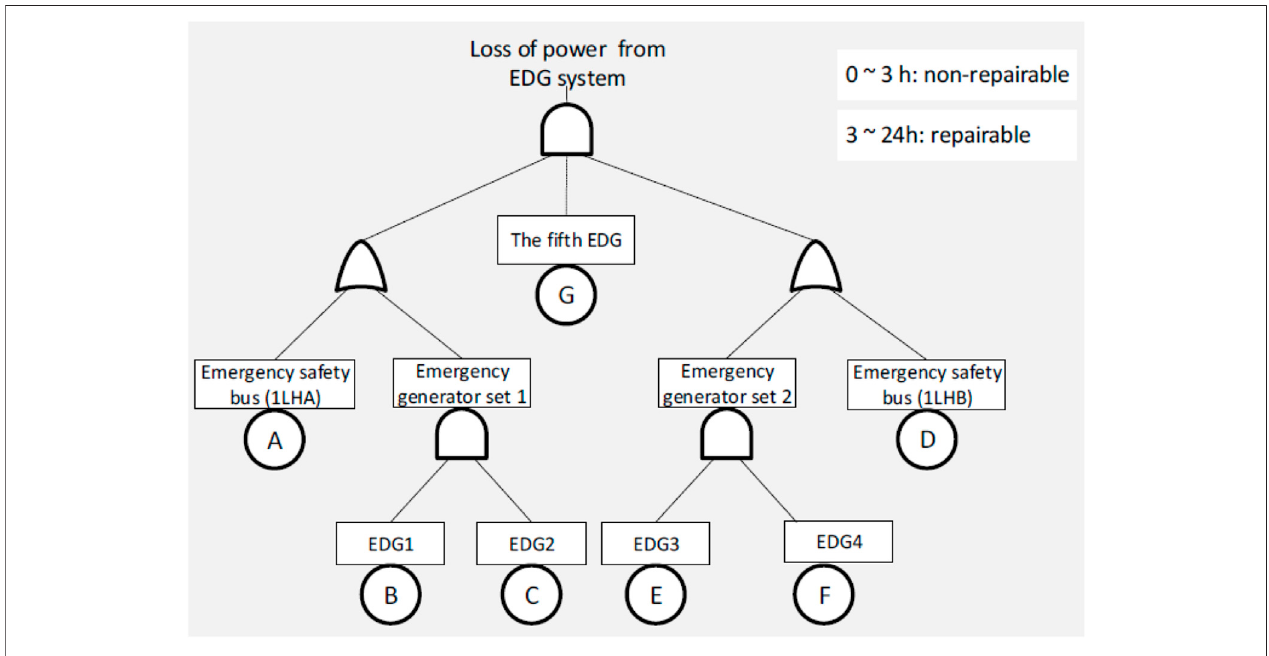
FIGURE 6 | SFT model of the GDS.